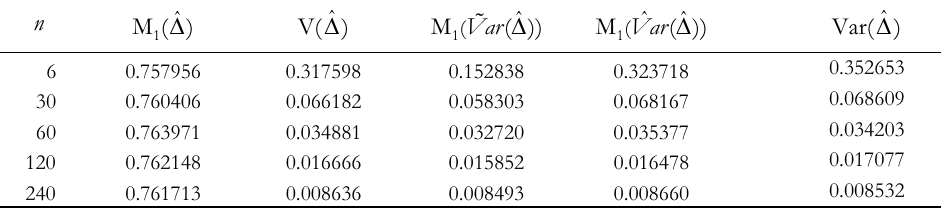
Simulation data for the estimation of )ˆ Var( (cid:39) by and ,